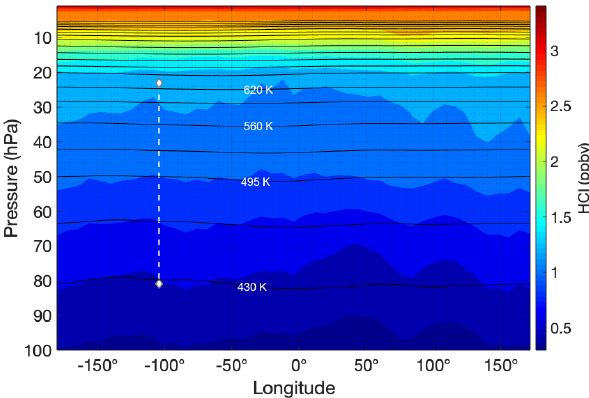
Figure 14. Same as for Fig. 13 except the meridionally averaged HCl profile is shown as a function of longitude